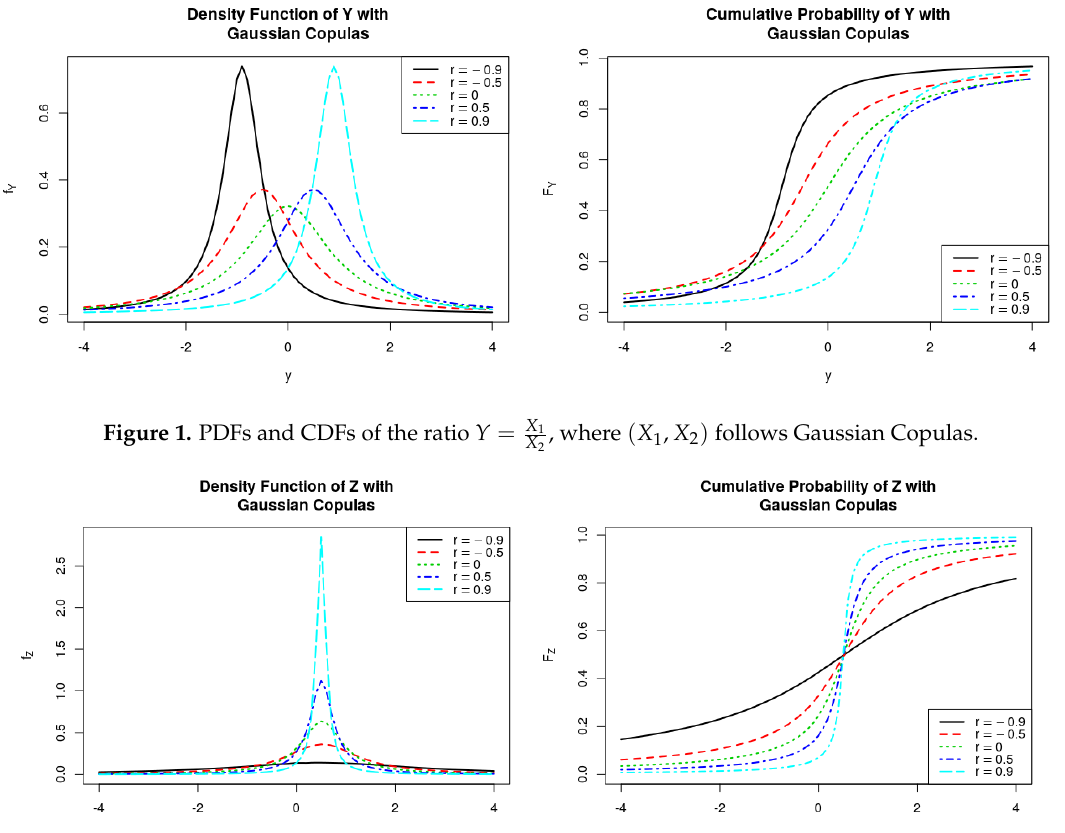
Figure 2. PDFs and CDFs of the ratio Z = X 1